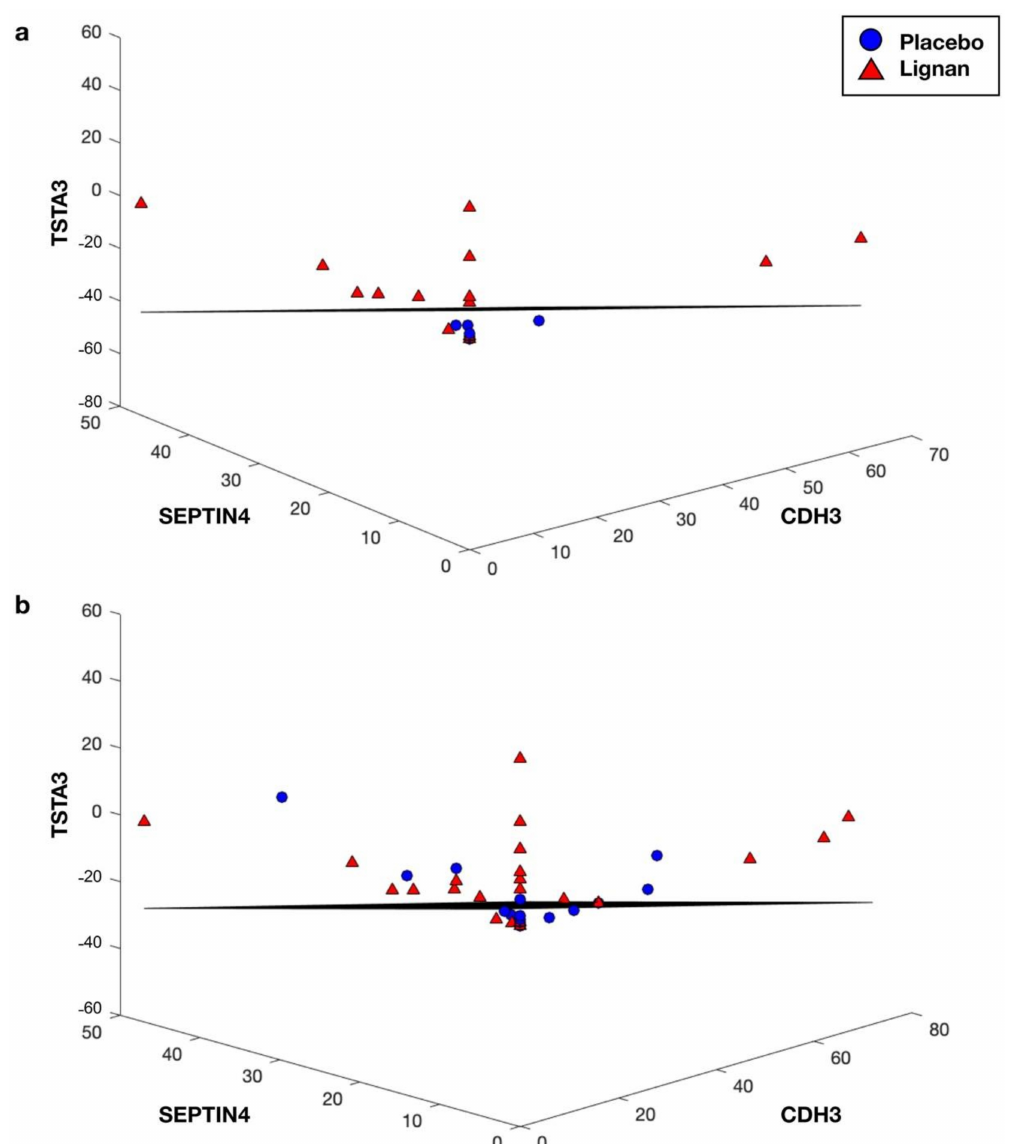
Figure 3. The top performing low-ENL phenotype three-gene classifier based on TSTA3, SEPTIN4 and CDH3 expression: ( a ) low-ENL participants only (12 placebo, 15 lignan); ( b ) all participants (25 placebo, 29